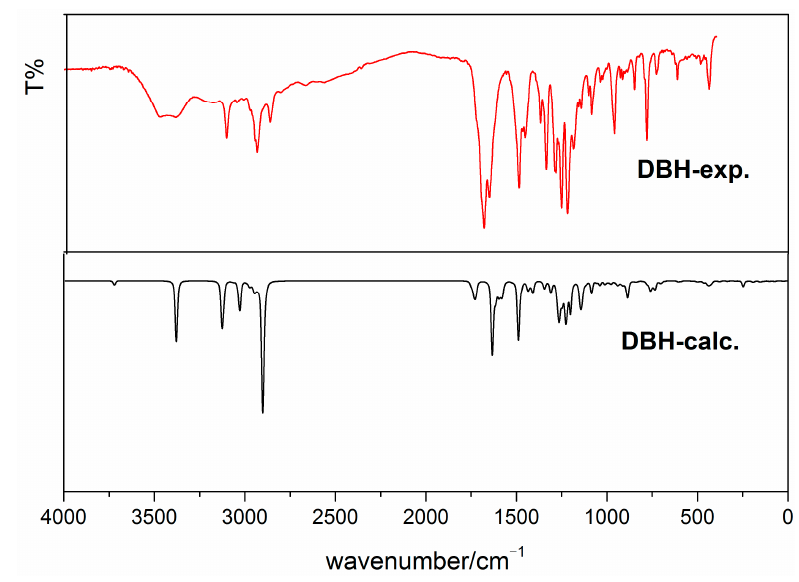
Figure 4. Experimental and calculated IR spectra of DBH .